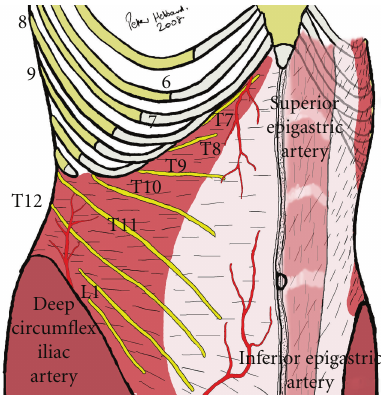
Figure 3: Typical distribution of nerves in the TAP. Generously shared from the personal files of Prof. P.